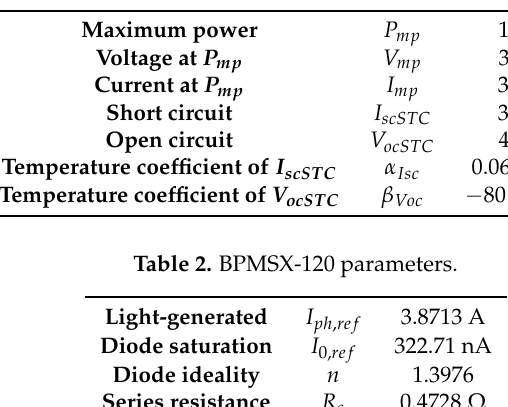
Table 1. BP MSX-120 datasheet parameters.